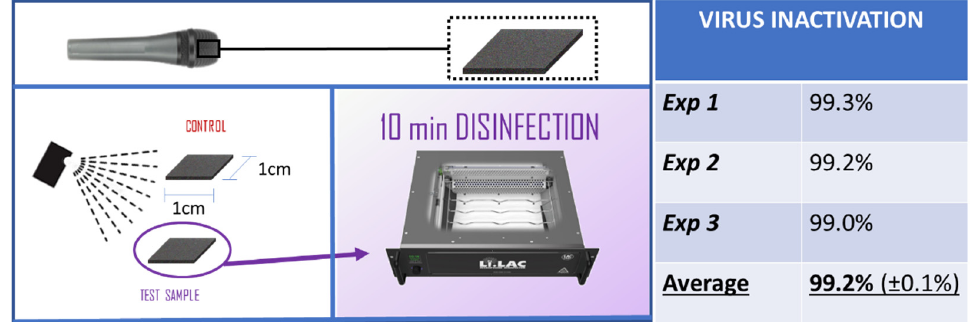
Figure 3. Representation of the spray deposition of virus onto a foam from the inside of the micro- phone, and representative results from disinfection experiments.